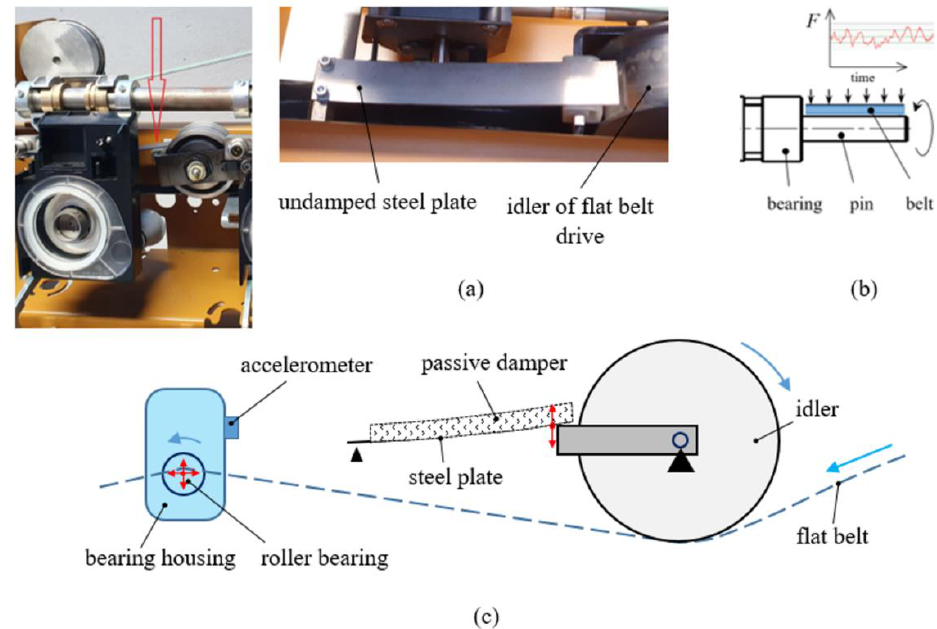
Figure 1. Idler and undamped steel plate–view and detail ( a ), pressing force at bearing pin ( b ), and schematic of testing bench components ( c ).